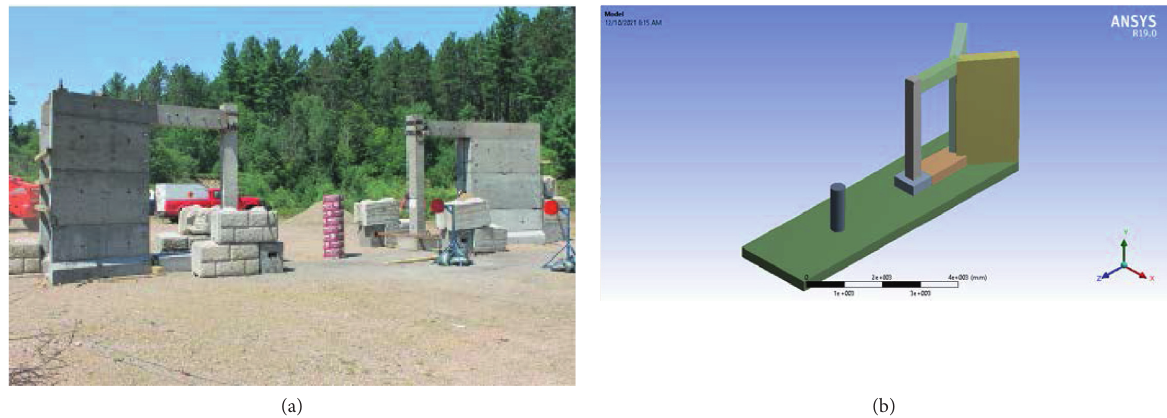
Figure 3: CONV_20 test column and location of 150kg ANFO explosive: (a) experiment carried out by Siba [20]; (b) AUTODYN FEA simulation.